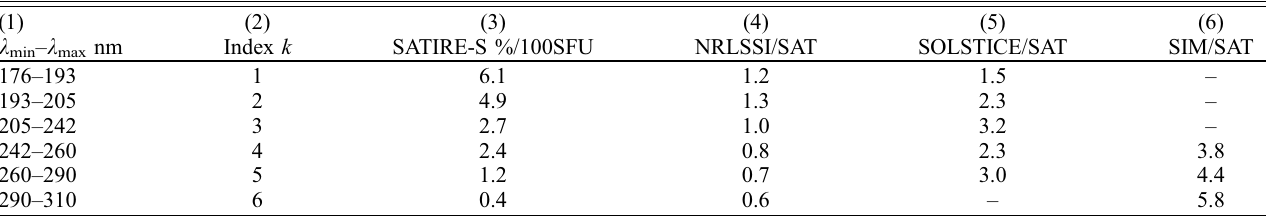
Table 1. SC flux changes within six wavelength bands per 100 SFU. The percentage change of SATIRE-S (SAT) is given in column 3. Changes in terms of multiples of SATIRE-S for NRLSSI, SORCE/SOLSTICE and SORCE/SIM are given in columns 4–6. SORCE/SIM v19 covers wavelengths from 240 nm, so only bands k = 4–6 are given.